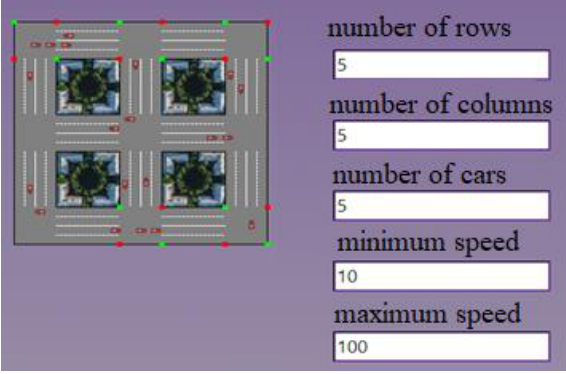
Figure 4. Simulation